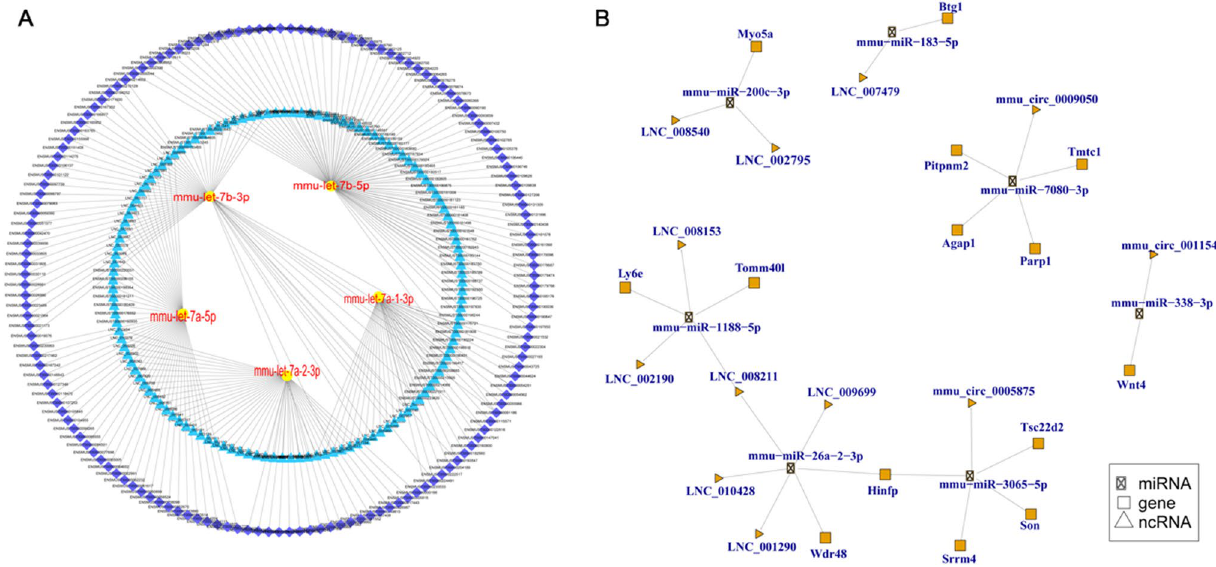
Figure 5. The competing endogenous RNA (ceRNA) network of micRNA, mRNA, lncRNA, and cirRNA. ( A ) The top 300 ceRNA network of whole of miRNA, mRNA, lncRNA, and cirRNA. A yellow ellipse represents miRNA, blue triangle represents lncRNA (unknown: LNC, known: ENSMUST), and purple rhombus represents mRNA. No cirRNA were involved in the top 300. Lines represent correlations. (B) CeRNA network of differentially expressed miRNA, mRNA, lncRNA, and cirRNAs. mmu-miR-200c-3p-mediated ceRNA crosstalk between LNC_008540, LNC_002795 and myosin VA (Myo5a, ENSMUST00000123128). mmu- miR-183-5p mediated ceRNA crosstalk between LNC_007479 and BTG anti-proliferation factor 1 (Btg1, ENSMUST00000038377). LNC_008211 is co-expressed with mmu-miR-1188-5p-mediated ceRNA and mmu-miR-26a-2-3p-mediated ceRNA. Histone H4 transcription factor (Hinfp, ENSMUST00000216508) is co-expressed with mmu-miR-26a-2-3p-mediated ceRNA crosstalk and mmu-miR-3065-5p -mediated ceRNA